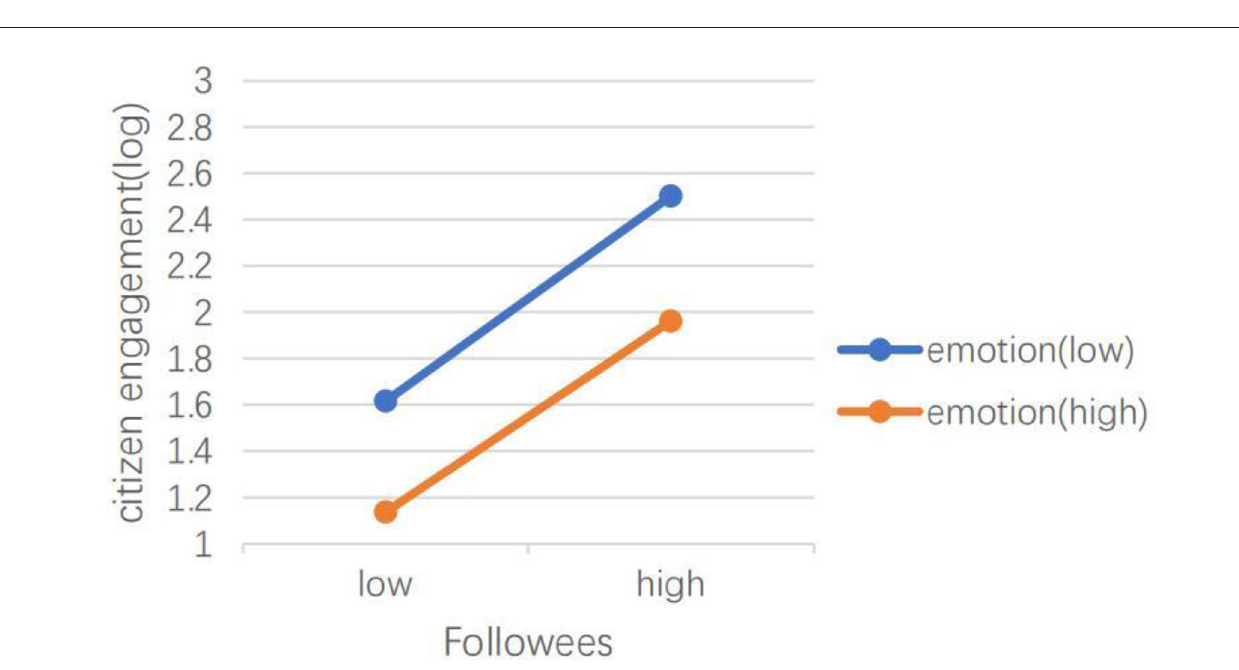
on CEGSM (22). The results of Stone and Can showed that the number of third-person pronouns was positively correlated with the number of reposts and likes (51). After the introduction